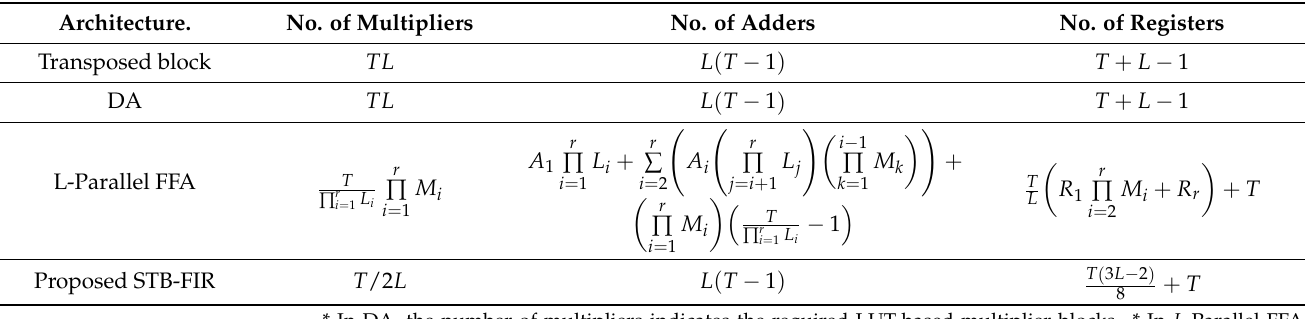
Table 1. Comparisons of various parallel FIR